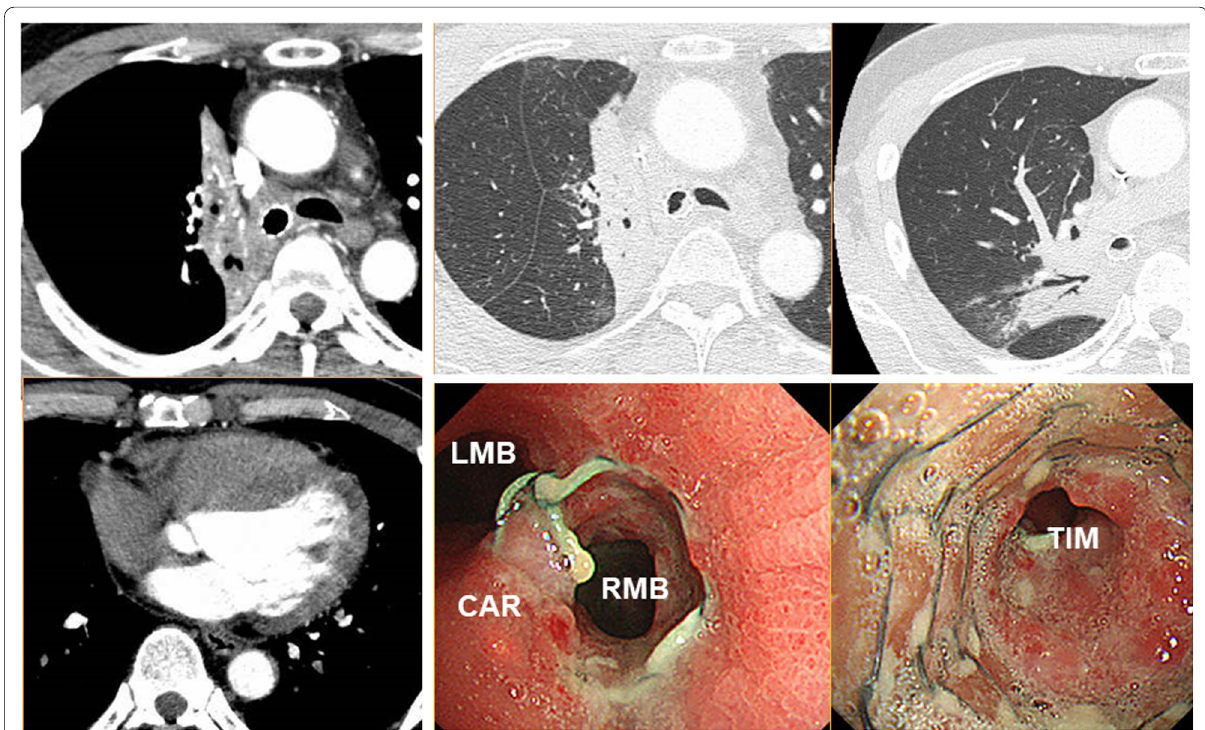
Fig. 3 Computed tomography (CT) after bronchial stenting and immuno-chemo-radiotherapy showed dramatic tumor shrinkage and disappearance of pericardial effusion (left), and also showed persistent lung infection (right upper) associated with sent placement (right lower). Microbiological test of the “green–blue” sputum collected by deep coughing and by bronchoscopy revealed bacterial phagocytosis by neutrophils and growth of bacteria that was identified as Pseudomonas aeruginosa . CAR, carina; LMB, left main bronchus; RMB, right main bronchus; TIM, truncus